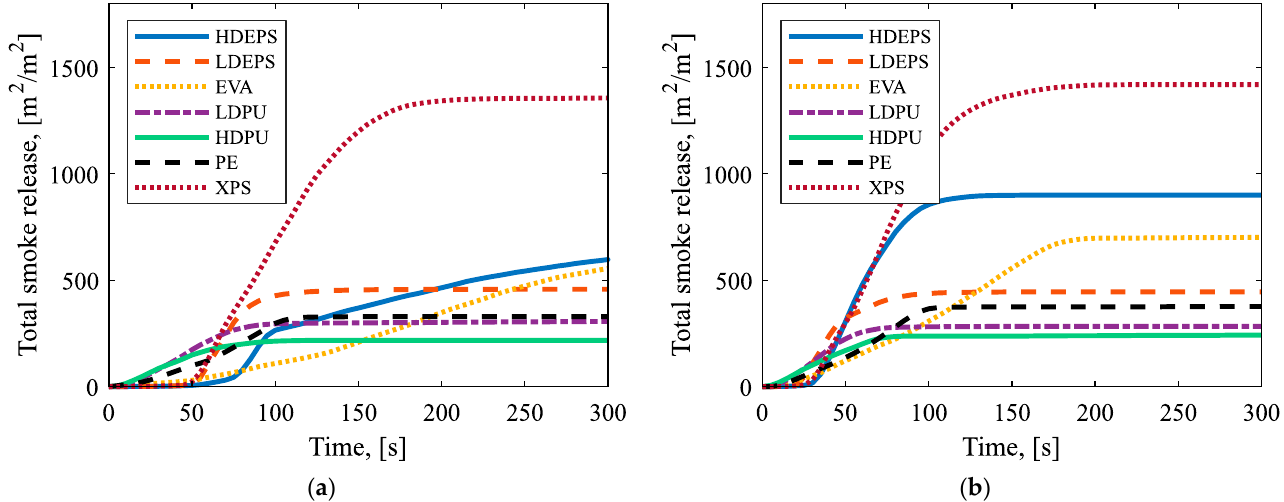
Figure 4. TSR time profile of polymer samples at ( a ) 35 kW/m 2 ; ( b ) 50 kW/m 2 heat fluxes.